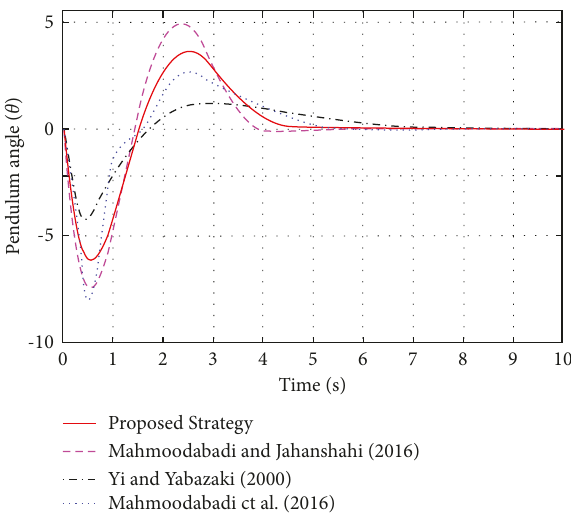
Figure 8: Pole angle based on the suggested fuzzy-PID controller and the techniques presented in references [28–30].